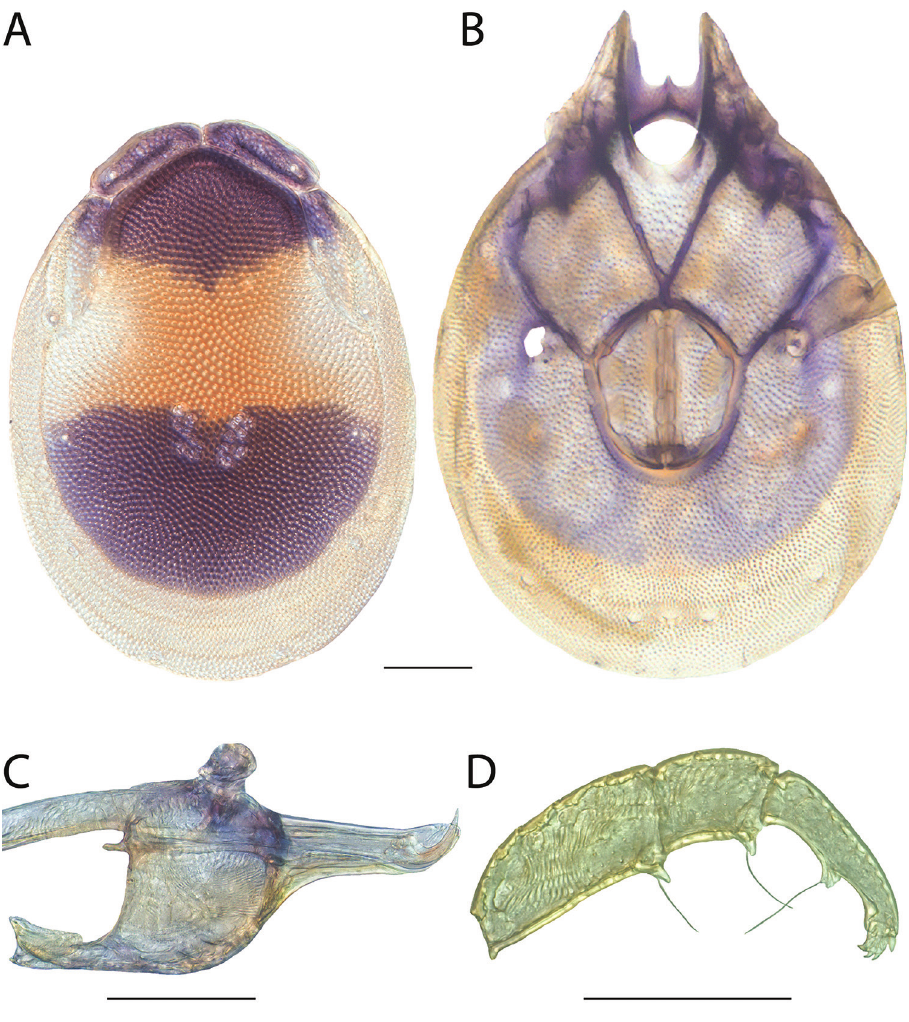
Figure 259. Torrenticola tysoni sp. n. female: A dorsal plates B venter (legs removed) C subcapitulum D pedipalp (setae not accurately depicted). Scale = 100